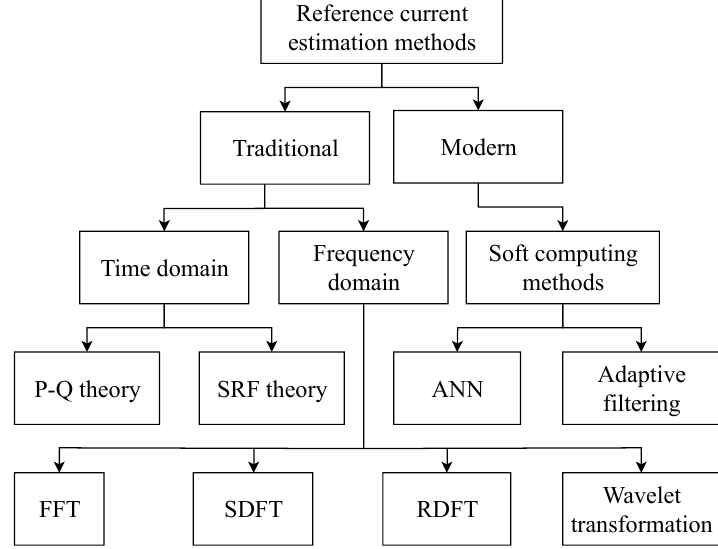
Figure 1. Schematic diagram of current estimation